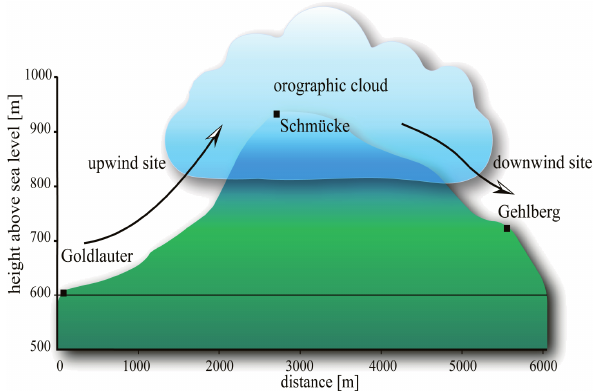
Fig. 1. Sketch of the terrain of the HCCT experiment. For an approaching flow from southwest, Goldlauter is Figure 1. Sketch of the terrain of the HCCT experiment. For an theupwindstationandGehlbergthedownwindstation. Thiswasthecaseforalldefinedfullcloudeventsgiven approaching flow from the southwest, Goldlauter is the upwind sta- in Table 1. tion and Gehlberg the downwind station. This was the case for all defined full cloud events given in Table